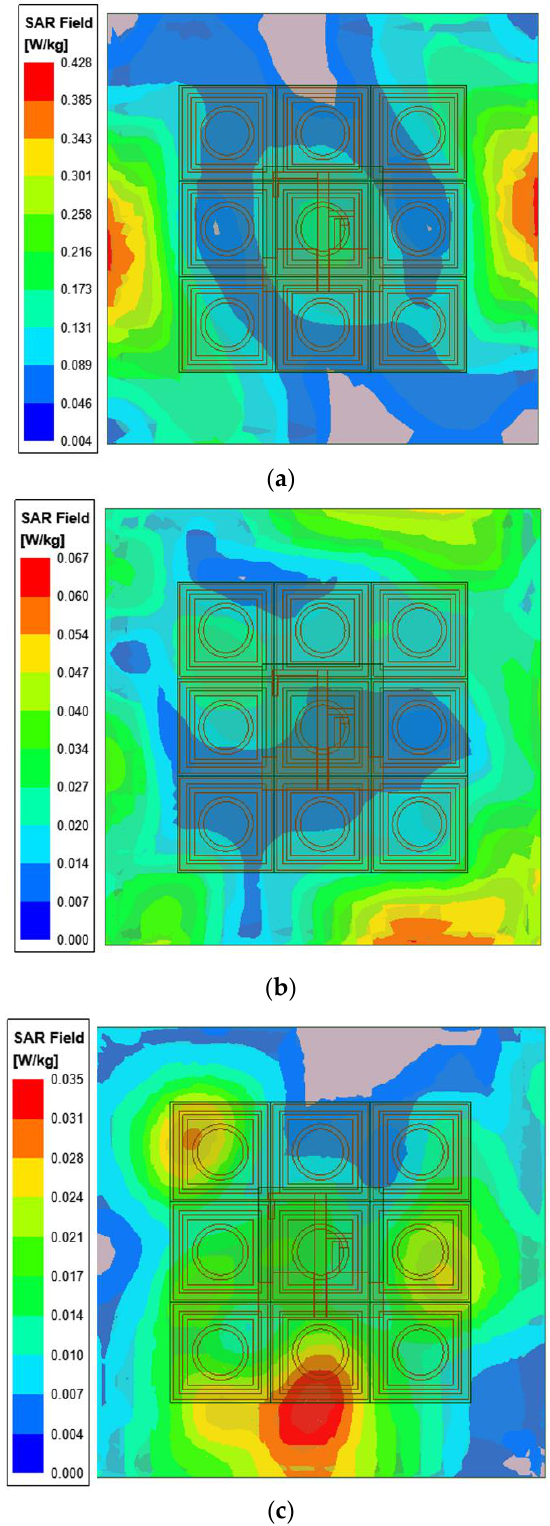
Figure 12. SAR levels of the integrated antenna at: ( a ) 2.45 GHz, ( b ) 3.5 GHz, and ( c ) 5.8 GHz.